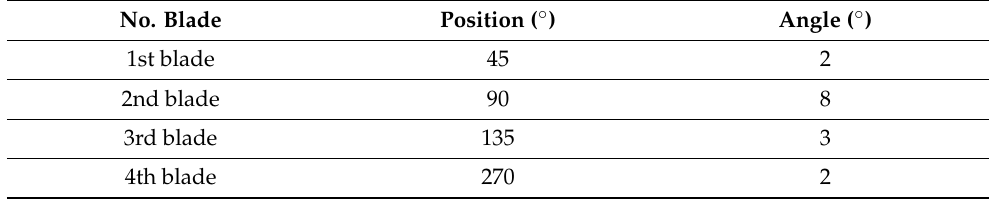
Table 7. Pitch angles of initial reference pre-swirl